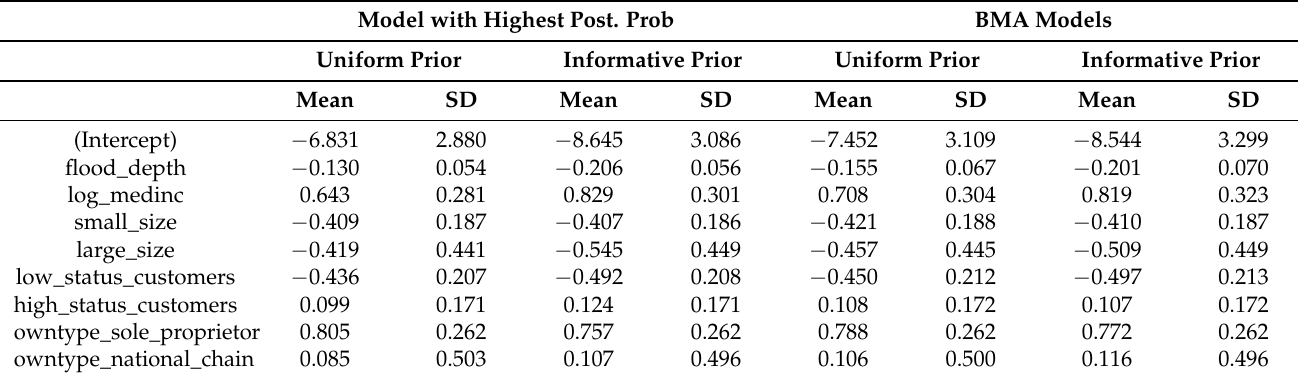
Table 3. Summary statistics of the covariate coefficients for the model with the highest probability (under two different priors) and the BMA model (under two different priors.)